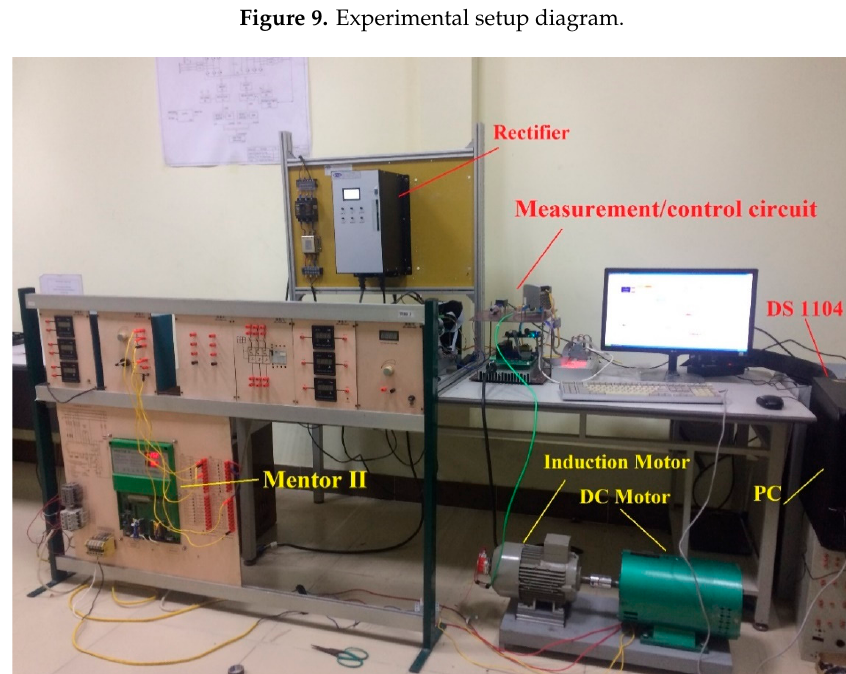
Figure 10. Experimental table using DS 1104.